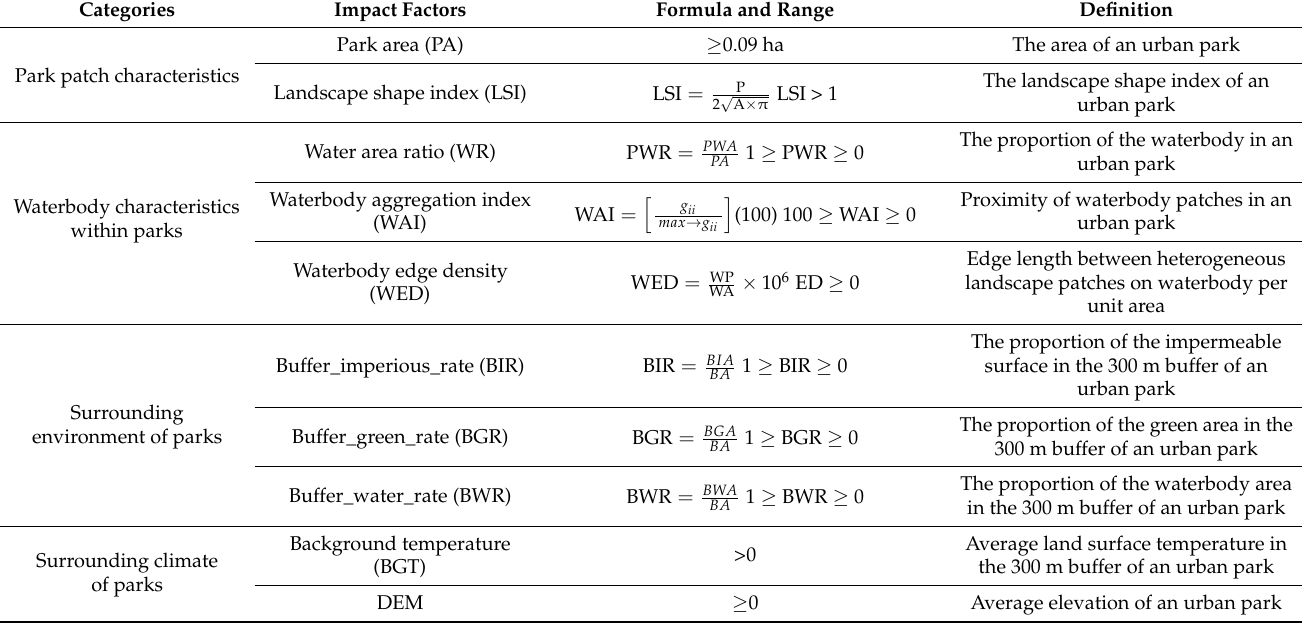
Table 1. Information on influencing factors on cooling effect of urban